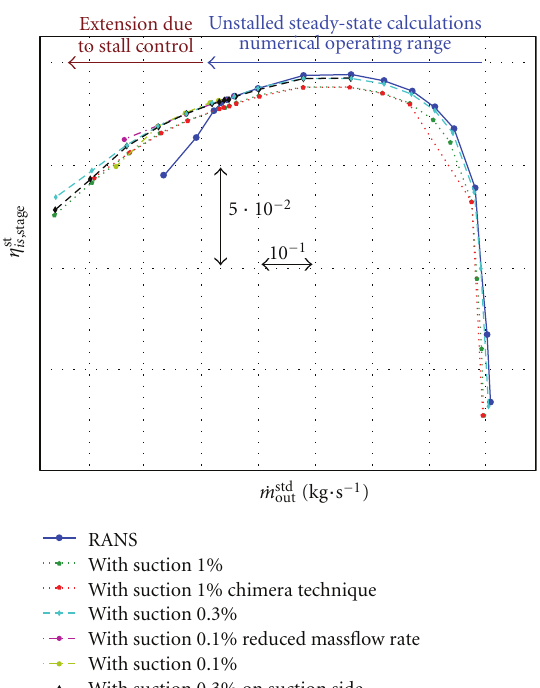
Figure 18: Isentropic e ffi ciency of the aspirated compressor